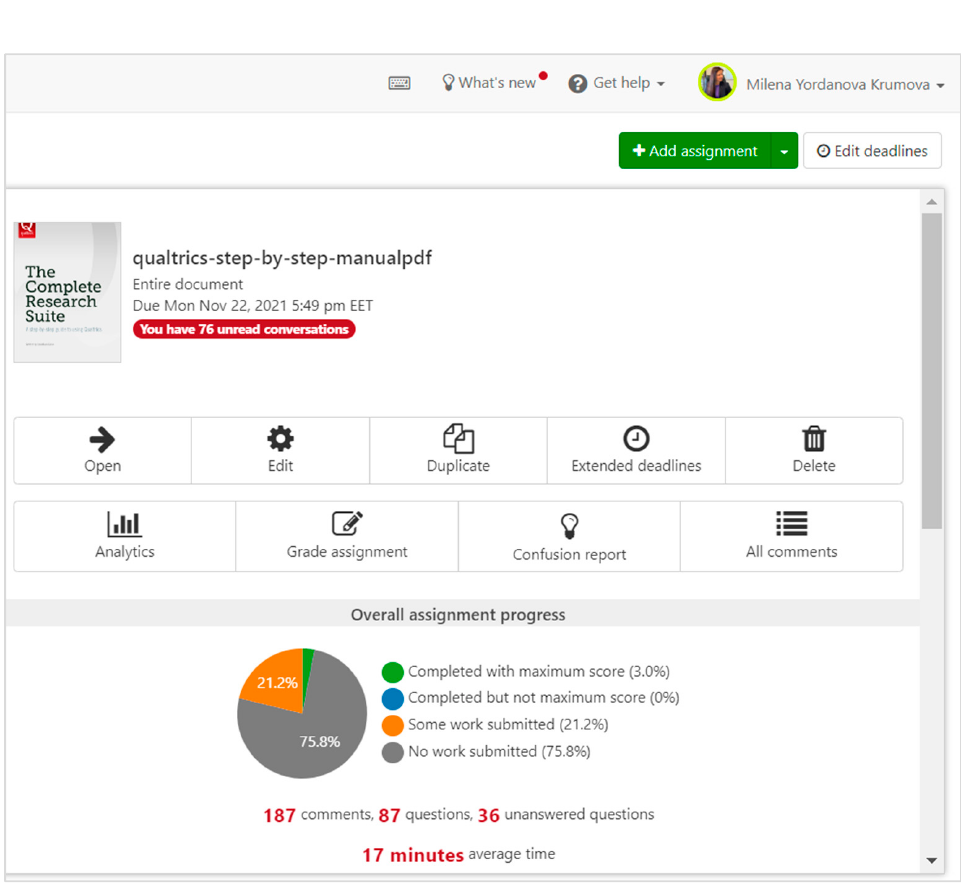
Figure 5. Perusall dashboard “Overall assignment progress” (Screenshot of class work).